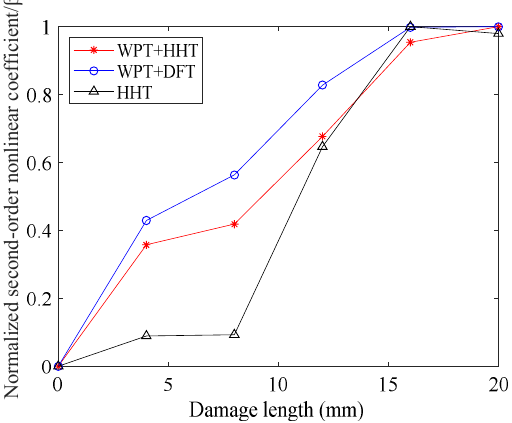
Figure 15. The changing curves of a normalized second-order nonlinear coefficient.